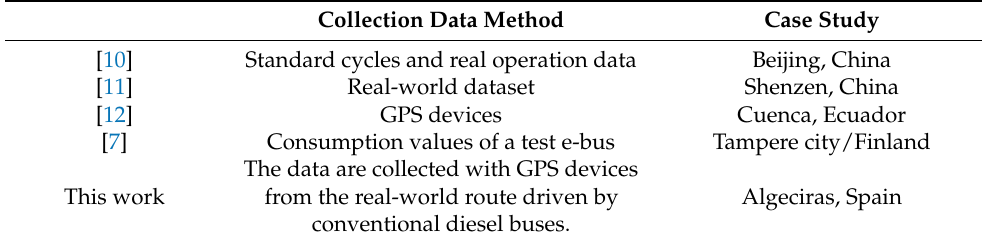
Table 1. Review of data collection methods to assess the energy consumption of e-buses.